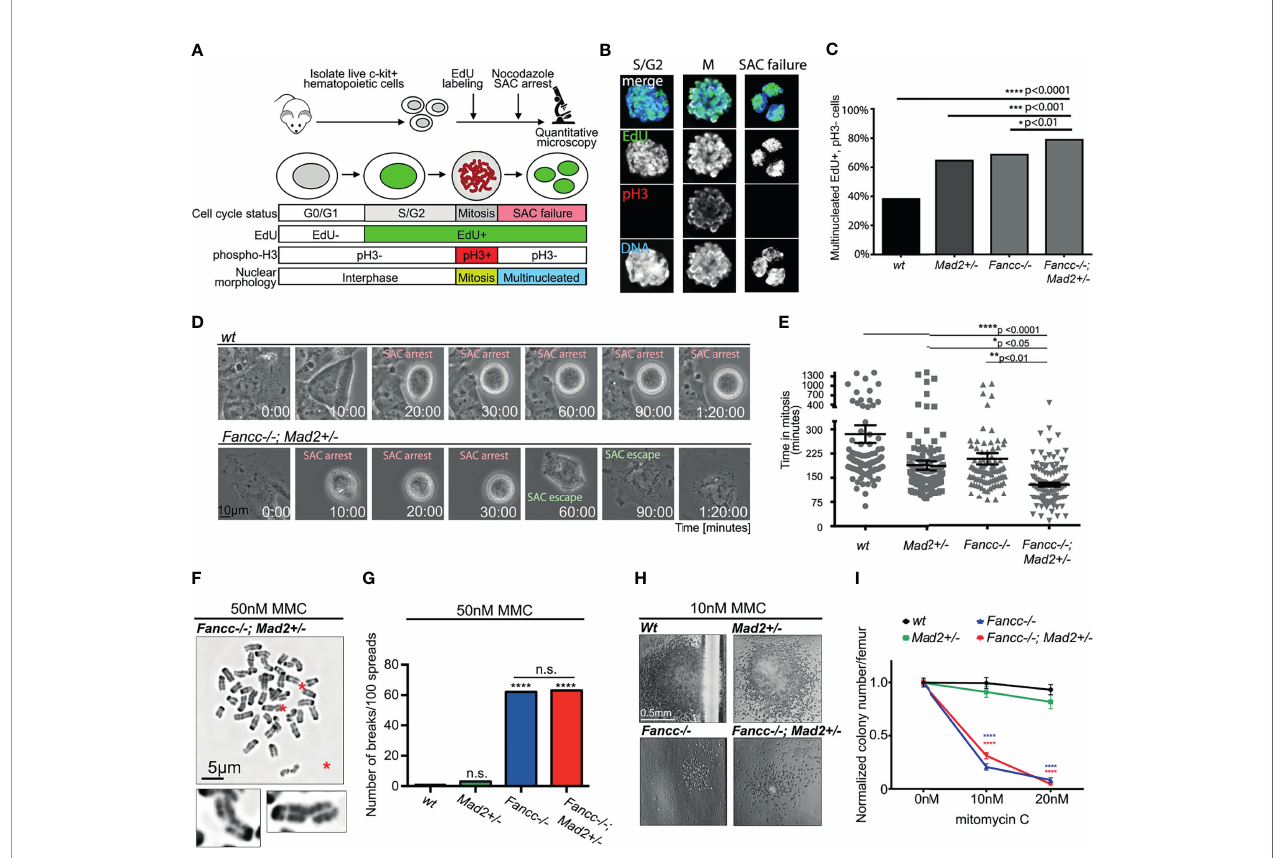
FIGURE 4 | Exacerbation of SAC defect but not of DNA cross-linker hypersensitivity in Fancc-/-; Mad2+/- mice. (A) Graphic illustrating assay design for quantifying SAC impairment in primary low-density mononuclear hematopoietic cells (LDMNCs). Live c-kit+ cells were labeled with EdU and treated with 100 ng/mL nocodazole for 12 hours. Immuno fl uorescence microscopy quanti fi es cells that progressed through S-phase (EdU+) and escaped nocodazole-mediated SAC arrest to exit mitosis (pH3-) and undergo multi-nucleation (DNA). (B) Representative immuno fl uorescent images of c-kit+ cells in S/G2 phase (EdU+, pH3-, single nucleus), mitosis (M) (EdU+, pH3+, condensed chromosomes) and after SAC slippage (EdU+, pH3-, multi-nucleated). (C) Percentage of multinucleated Edu+, pH3- cells in wt, Mad2+/- and Fancc-/- and Fancc-/-; Mad2+/- c-kit+ cells, suggesting that SAC de fi ciency in Fancc-/-; Mad2+/- c-kit+ cells is more severe compared to wt (p<0.0001), Mad2+/- (p<0.001) and Fancc-/- (p<0.01) genotypes. Fancc-/- and Mad2+/- cells demonstrate an intermediate SAC defect. For each genotype, >200 cells were quanti fi ed, and results were compared by Fisher ’ s exact test. (D) Representative time-lapse video frames of wt and Fancc-/-; Mad2+/ - BMDMs exposed to 2 m m taxol and imaged on a live